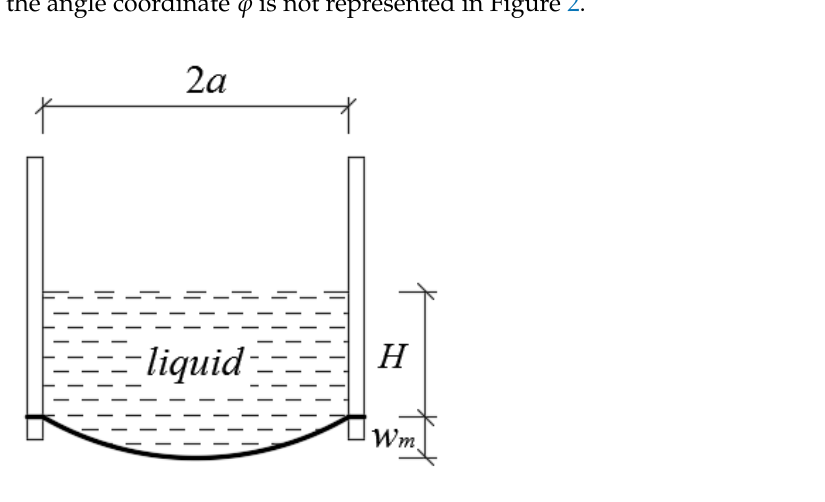
Figure 1. Geometry of the circular membrane under prescribed liquid along a diameter.